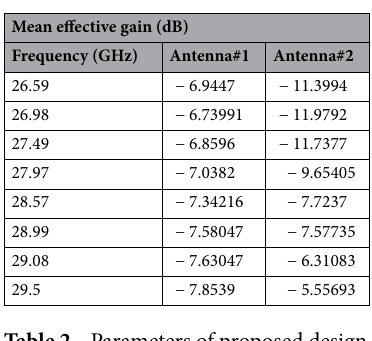
Table 2. Parameters of proposed design.